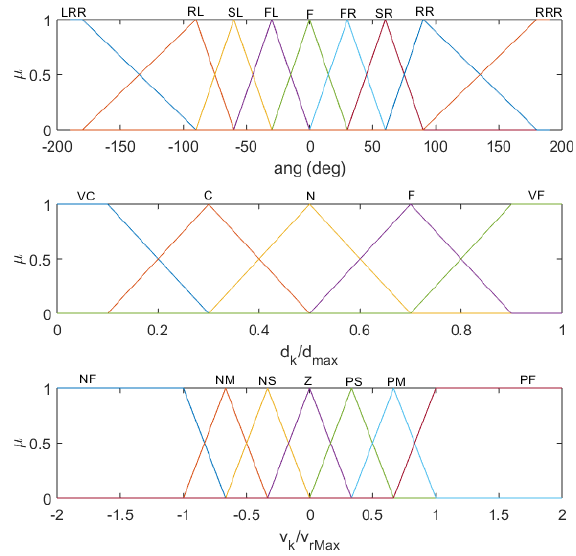
Figure 2. Input membership functions of the fuzzy